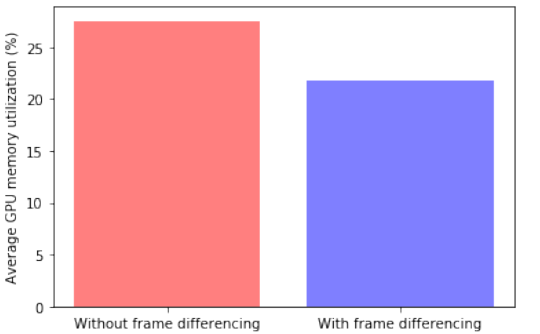
Figure 12. Impact of frame differencing on average GPU memory utilization. Average GPU memory utilization of AdaMM (dark shading) and additional GPU memory utilization of Baseline (light